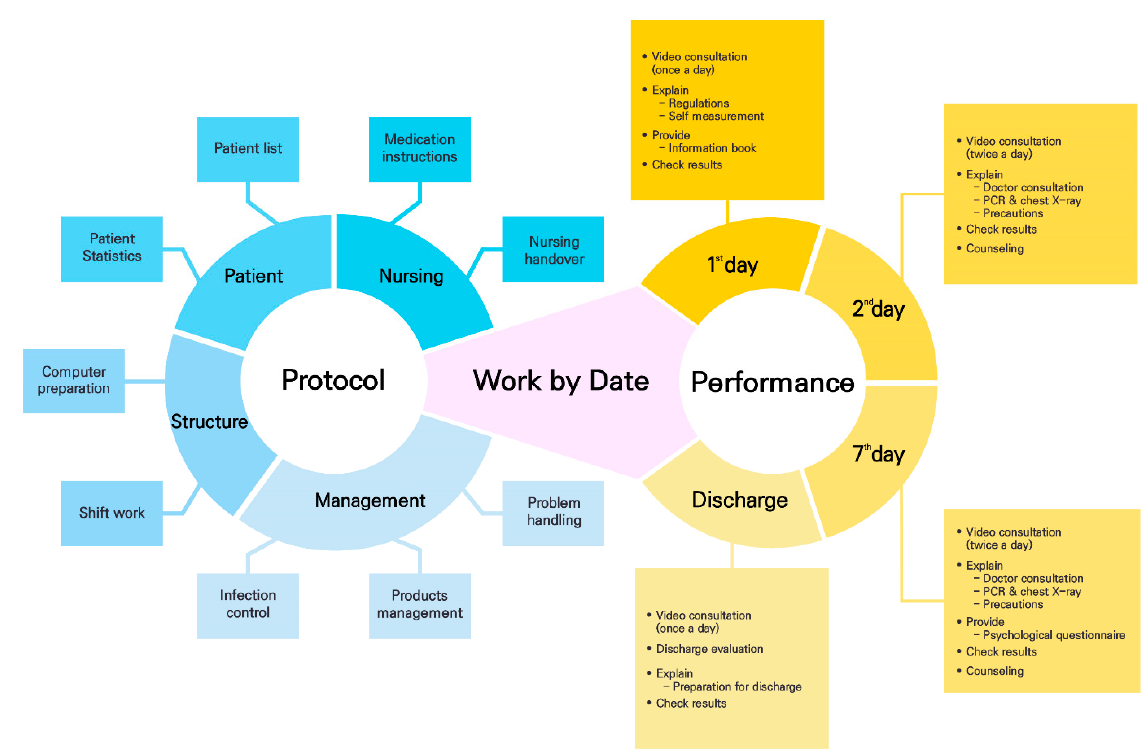
Figure 2. The protocol development process of Telenursing Service for the Community Treatment Center. Table 2. Changes in the medical records.